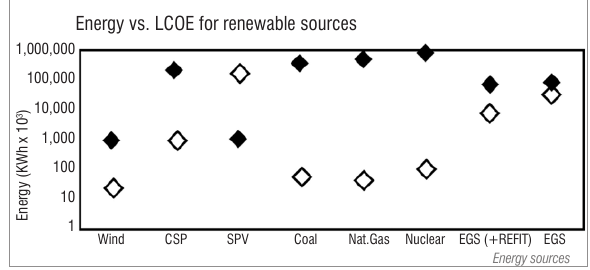
Graph comparing the levelised cost of electricity (LCOE) of enhanced geothermal systems (EGS) with those of other renewable energy sources. Black points correspond to the energy capacity and the white points correspond to the LCOE.